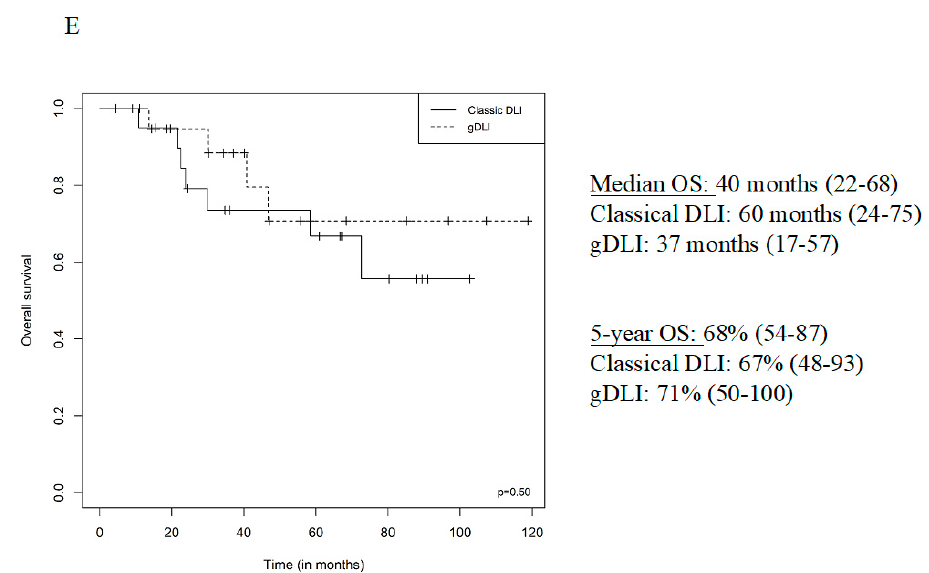
Figure 3. OS from first DLI according to DLI type (Classical, gDLI), ( A ) all patients, ( B ) multiple myeloma, ( C ) acute myeloid leukaemia, ( D ) relapse indication, ( E ) pre-emptive indication.